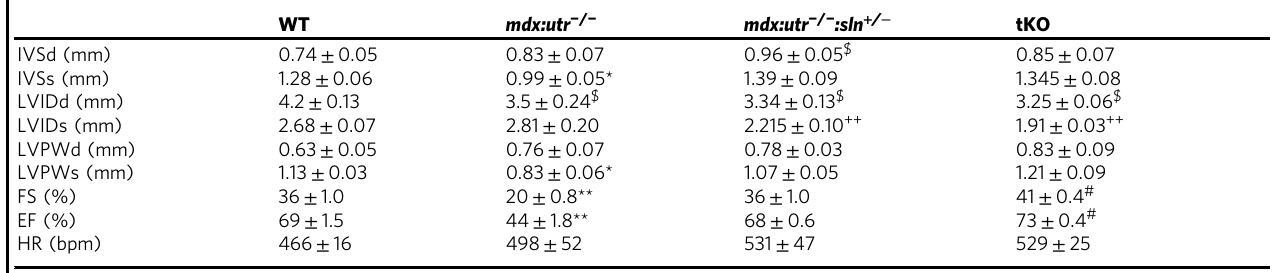
Table 1 Baseline echocardiographic data of 3 – 4 month old